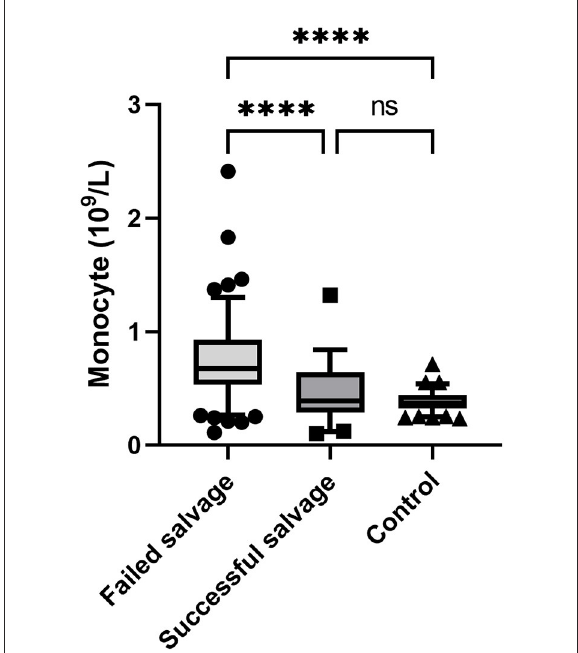
FIGURE1 Comparison of monocyte count among the three study groups. ****, P < 0.001; ns, non significant.